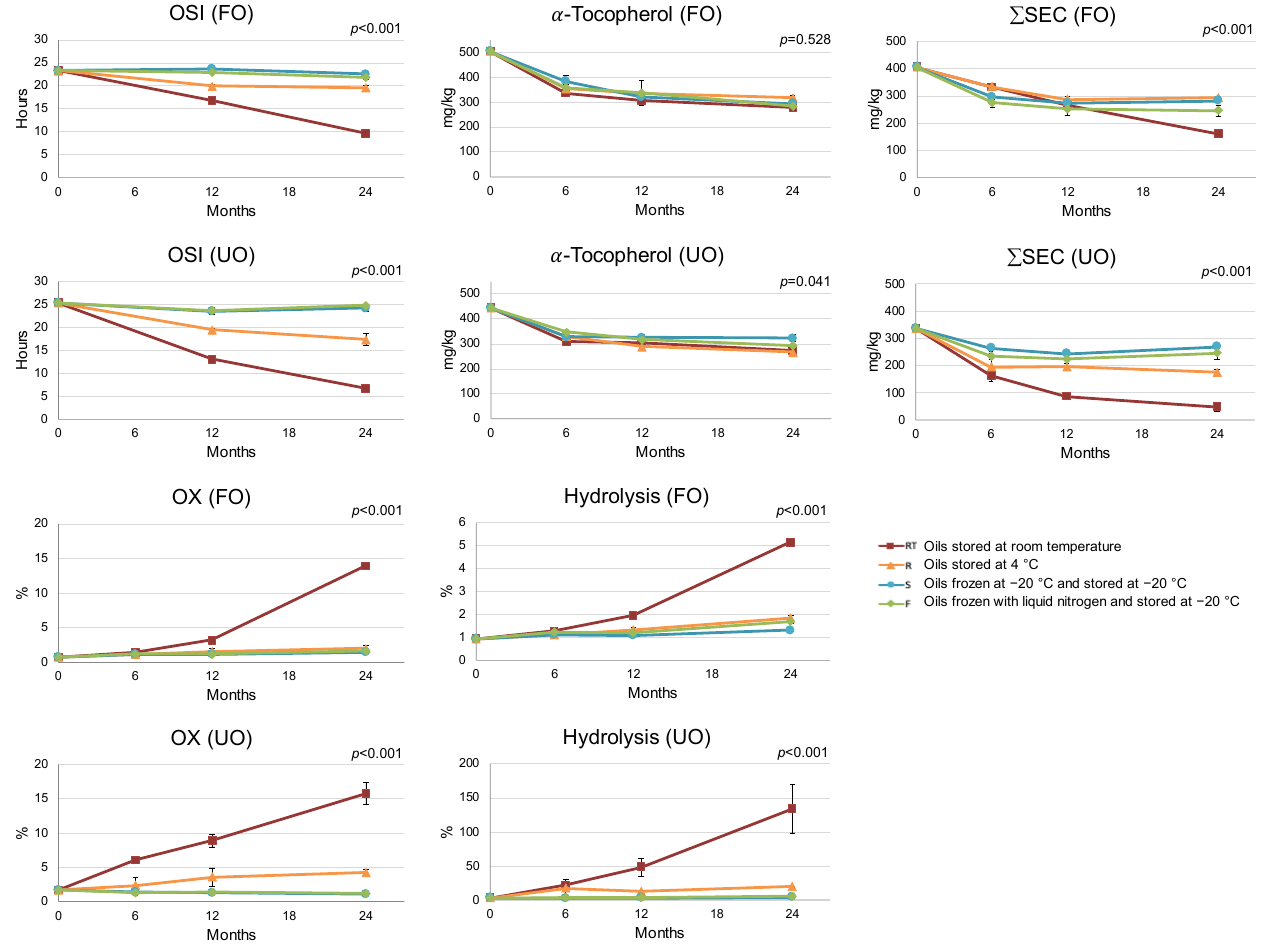
Figure 2. Interaction plot between storage conditions and time for the oxidative stability index (OSI), α -tocopherol content, secoiridoid derivatives content ( Σ SEC), oxidation rate of SEC (OX), and hydrolysis rate of SEC (Hydrolysis) of the filtered (FO) and the unfiltered (UO) oils. p ≤ 0.05 indicates significant interaction between the two factors (storage conditions and storage time). Error bars correspond to the standard deviation.